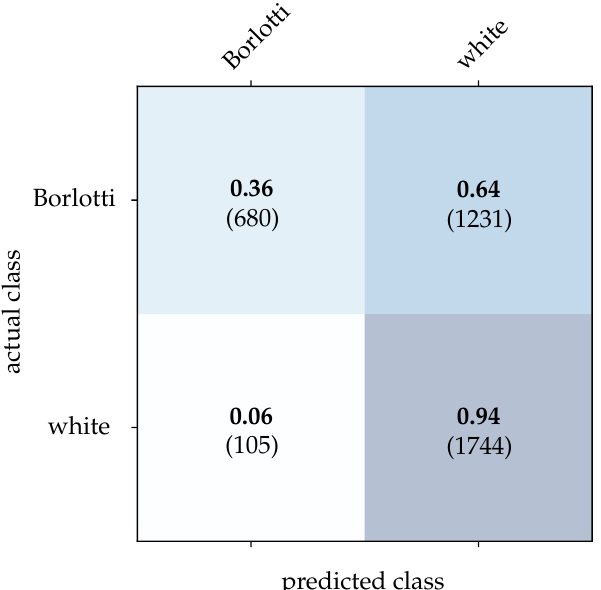
Figure 18. Classification results using the SNN [20] and the beans dataset. The bold values denote the relative frequency, the number in brackets the absolute number of samples.